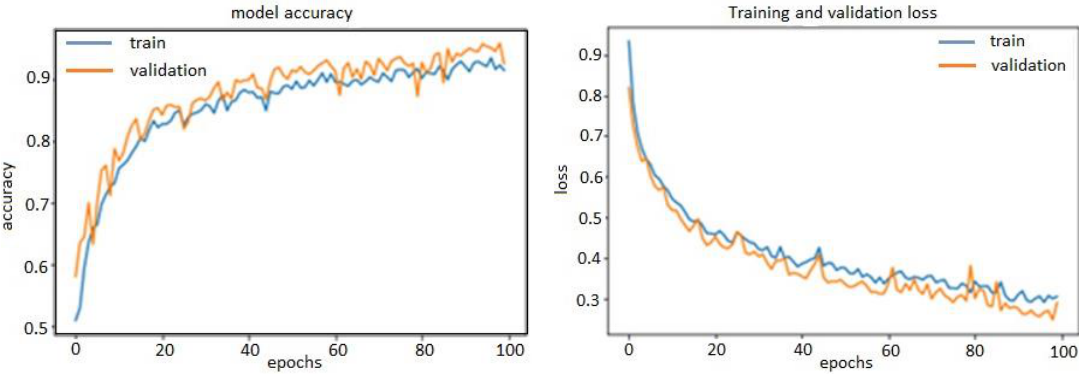
Figure 13. Accuracy and loss model of FFT_1D-CNN.